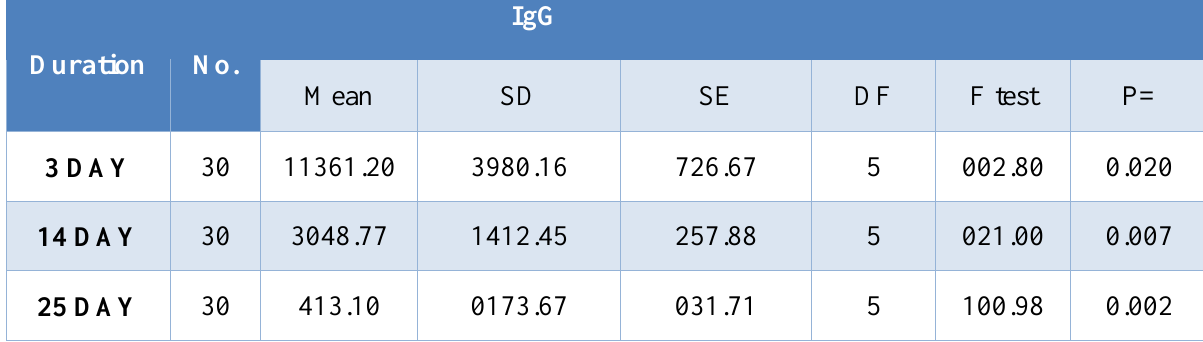
Table, 1: IgG antibody titer in experimental group before